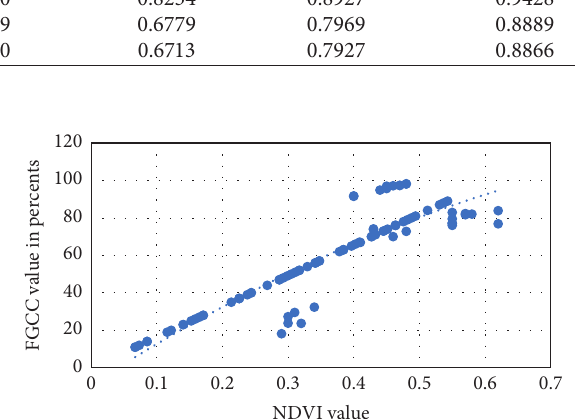
Figure 6: Approximation of the polynomial model for NDVI into FGCC conversion for grain corn.